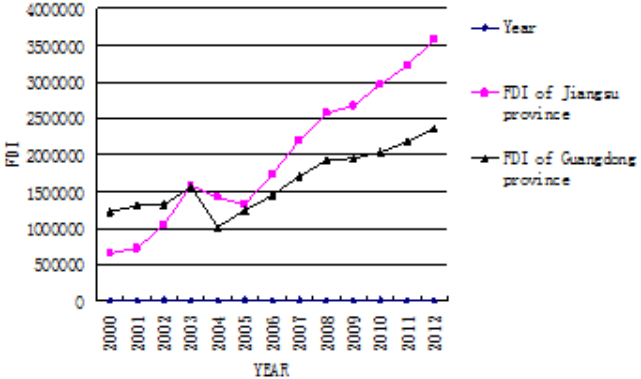
Figure 1. FDI of Jiangsu and Guangdong province in China